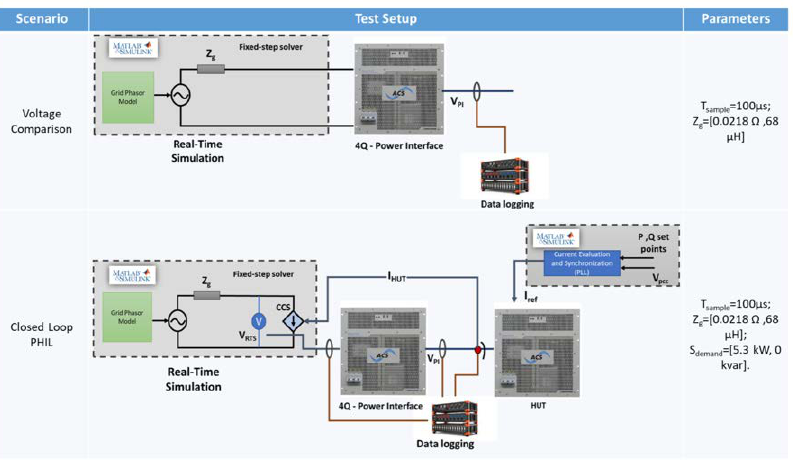
Figure 9. Scenarios to analyze the developed PHIL simulation environment, power components inaccuracies and